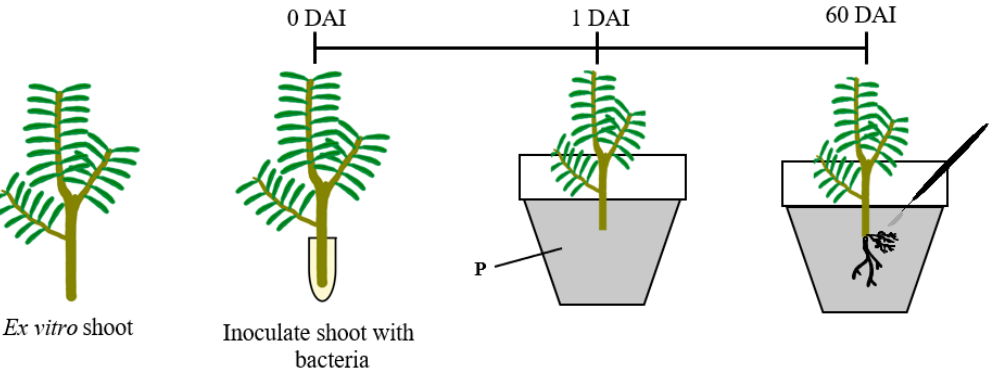
Figure 4. Schematic representation of the inoculation of ex vitro shoots by the dipping method. DAI: days after